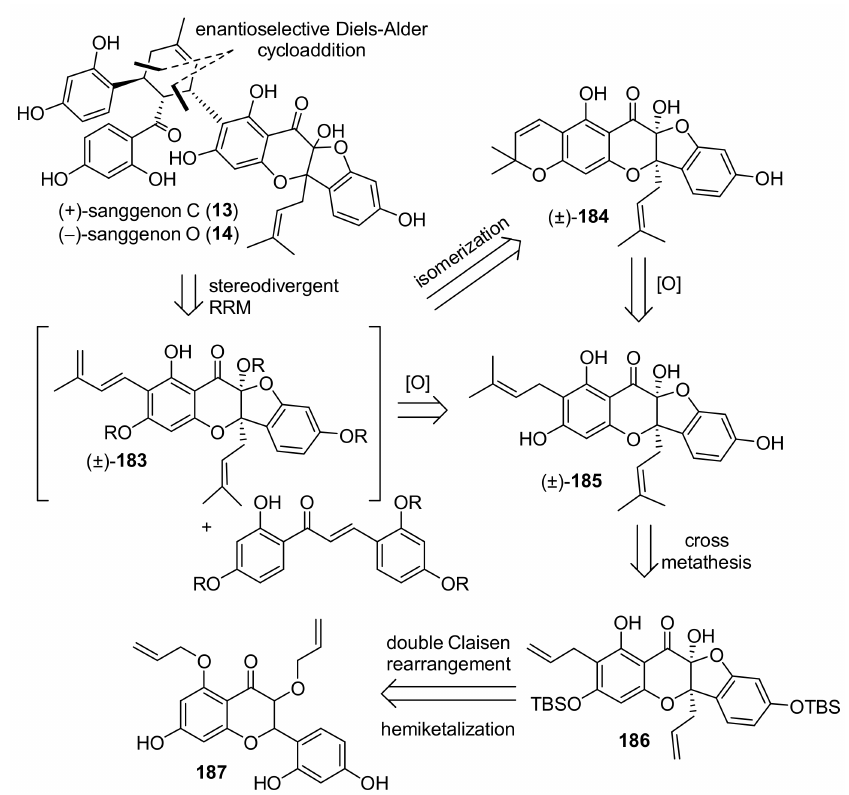
Figure 62. Retrosynthetic approach towards enantio-enriched sanggenons C and O, starting from sanggenon A ( 184 ) or sanggenol F ( 185 ).